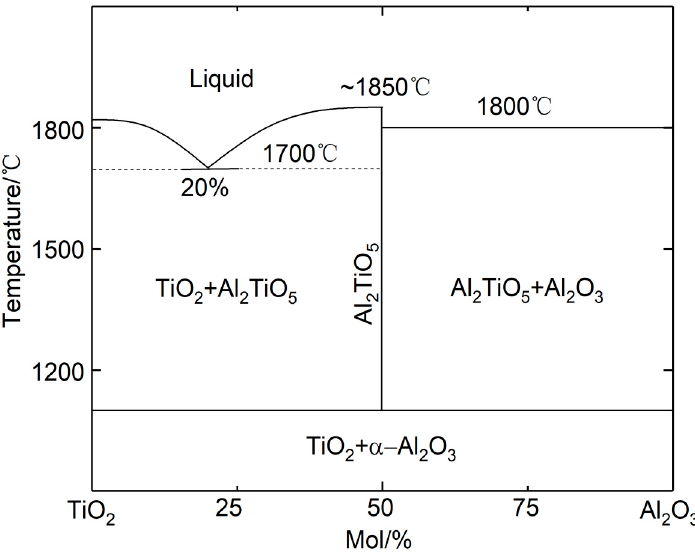
Figure 4. Phase diagram of TiO 2 -Al 2 O 3 .